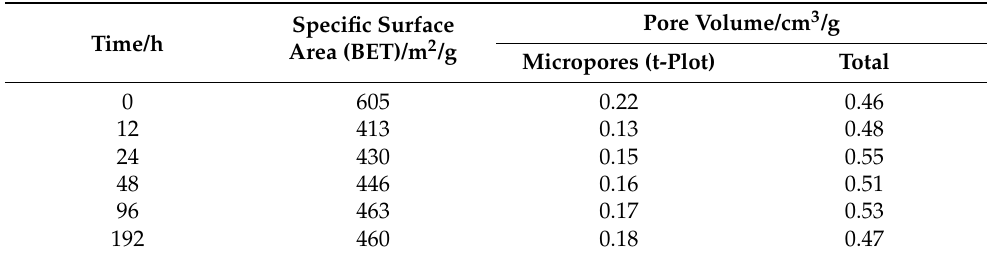
Table 3. Summary of different textural properties of the spray-dried products before (0 h) and after SAC. SAC was conducted at 150 ◦ C and resulted in the formation of pure MFI-type zeolite. Pore Volume/cm 3 /g Specific Surface Time/h Area (BET)/m 2 /g Micropores (t-Plot) Total 0 605 0.22 0.46 12 413 0.13 0.48 24 430 0.15 0.55 446 0.16 0.51 463 0.17 0.53 460 0.18